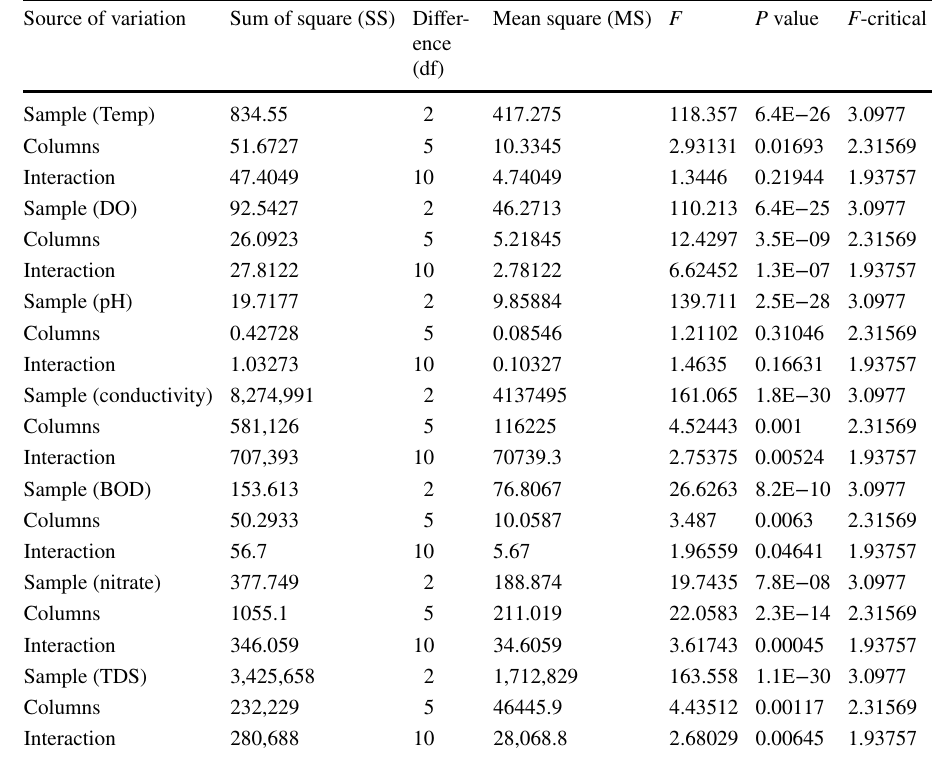
Table 6 The two-way ANOVA observation